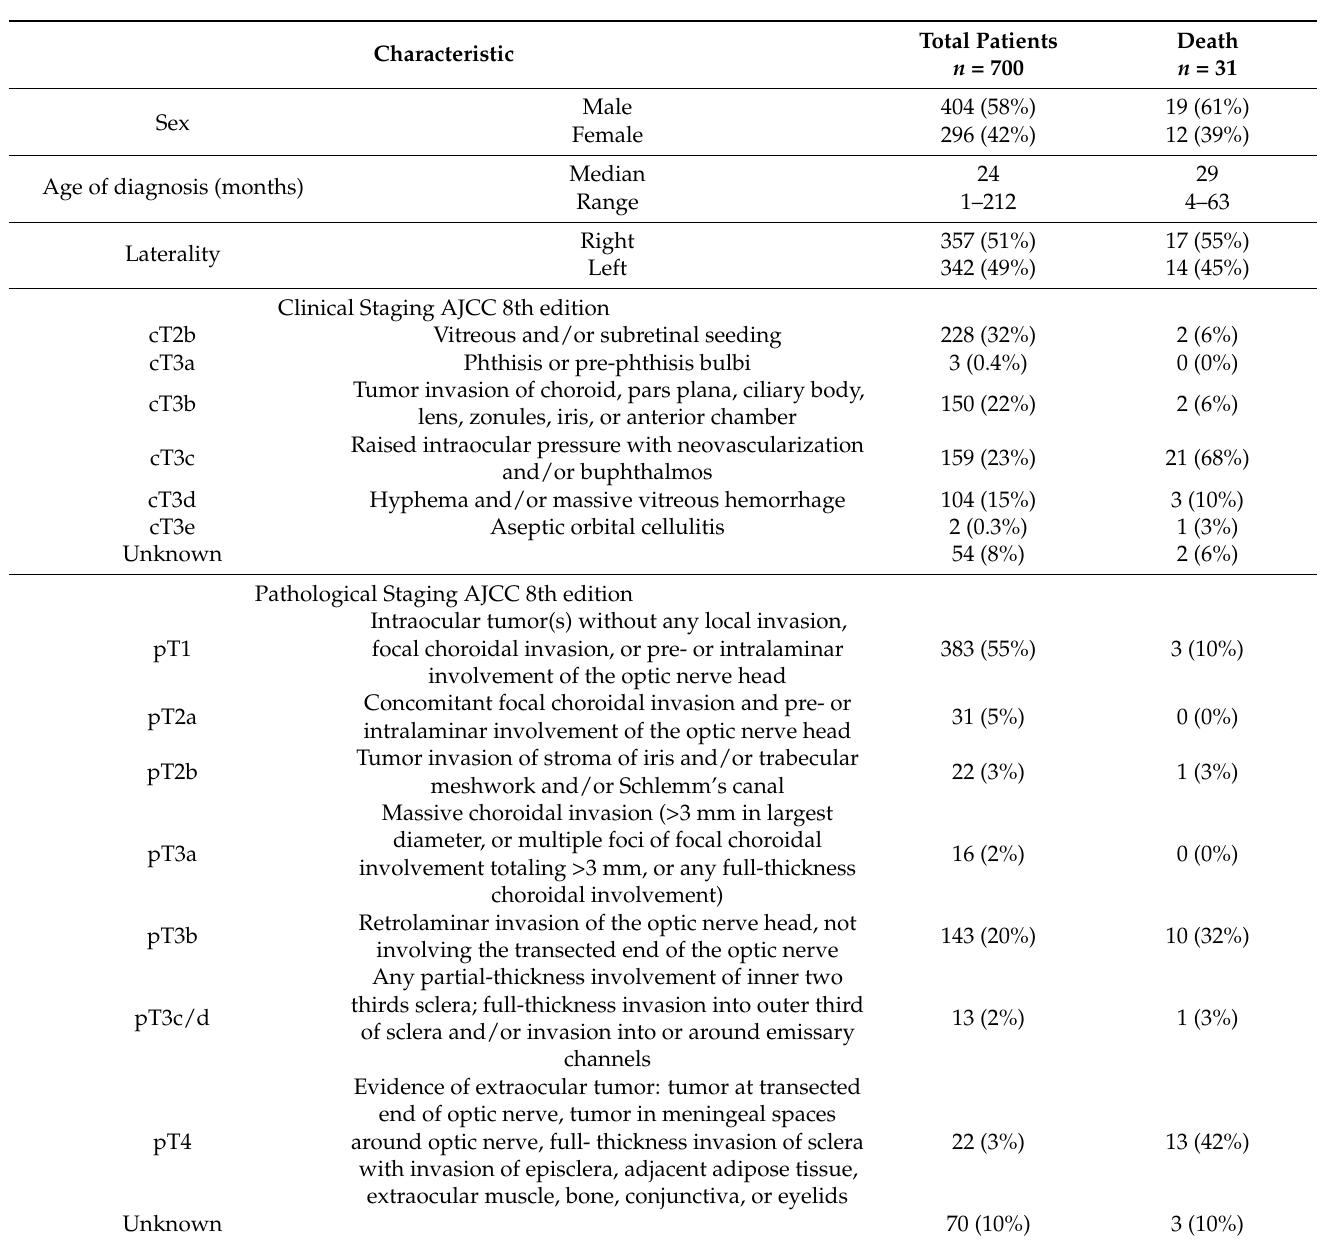
Table 1. Baseline clinical